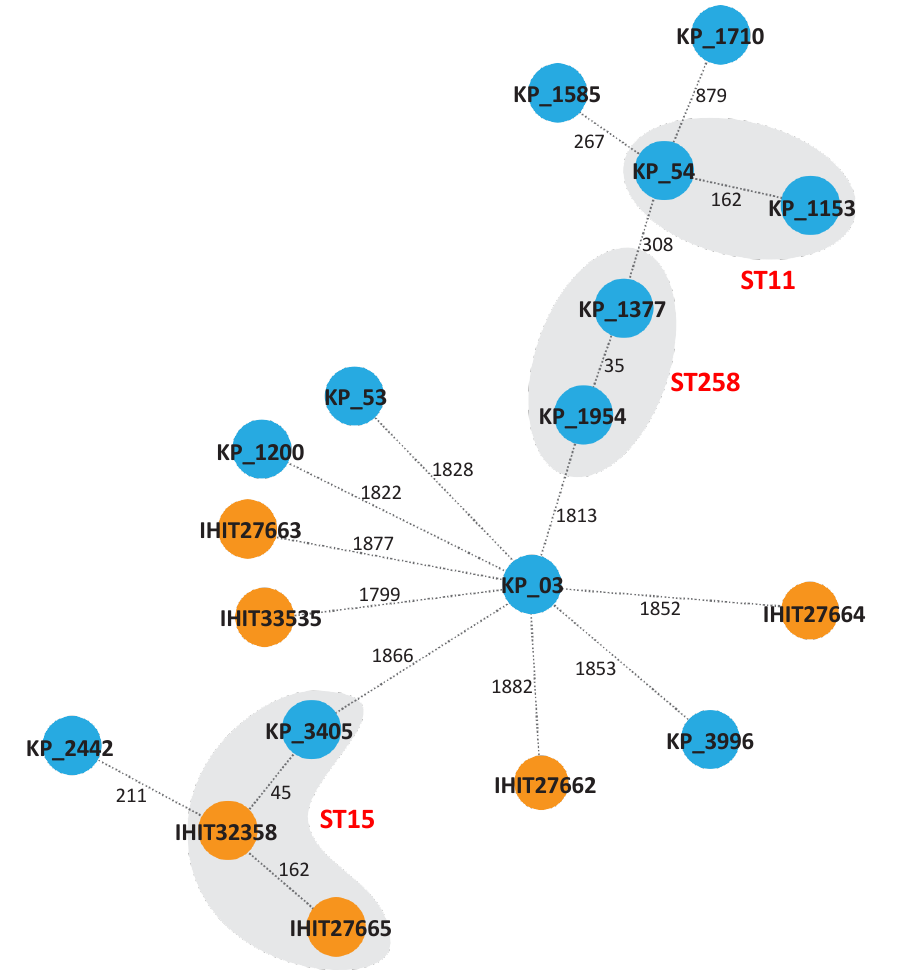
Figure 2. Genetic relatedness of colistin-resistant veterinary and human K. pneumoniae isolates. The minimum spanning tree was generated by cgMLST using SeqSphere (Ridom) based on 2358 alleles of the core genome. Numbers between the nodes indicate the number of different alleles. Veterinary isolates are depicted in orange; human isolates are shown in blue. Affiliation to the same sequence is indicated by the grey background.